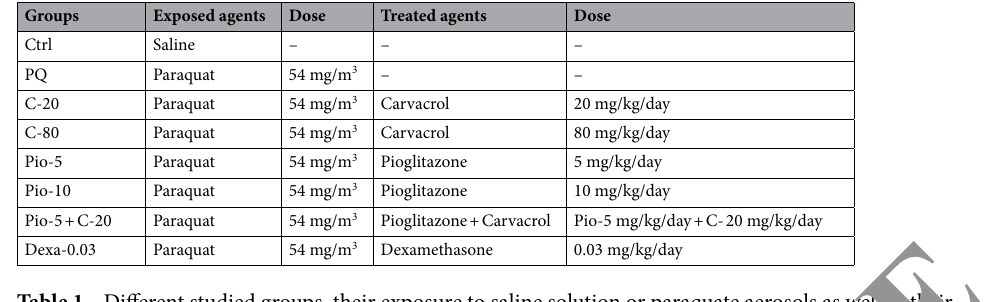
Table 1. Different studied groups, their exposure to saline solution or paraquate aerosols as well as their treatments (n = 6 in each group). PQ paraquat, C carvacrol, Pio pioglitazone, Ctrl